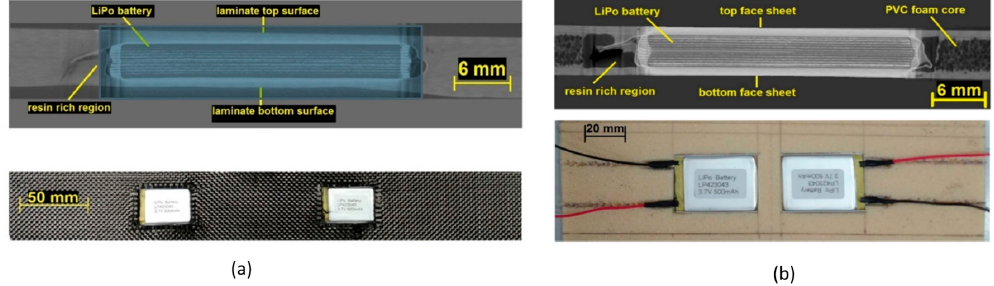
Figure 12. Structural composite battery configurations. ( a ) Laminated battery [8]. ( b ) Sandwich battery [10].